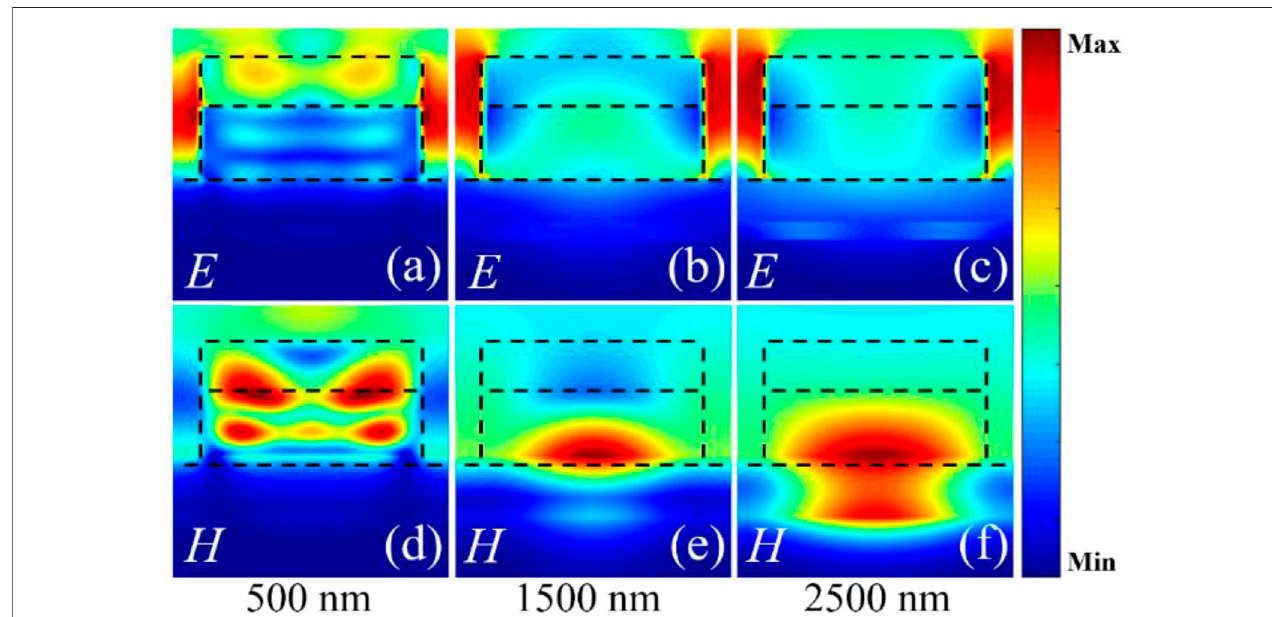
FIGURE 4 | (A-F) Electromagnetic fi eld distribution of structures at incident wavelengths of 500 nm, 1,500 nm and 2,500 nm ( xoz plane).